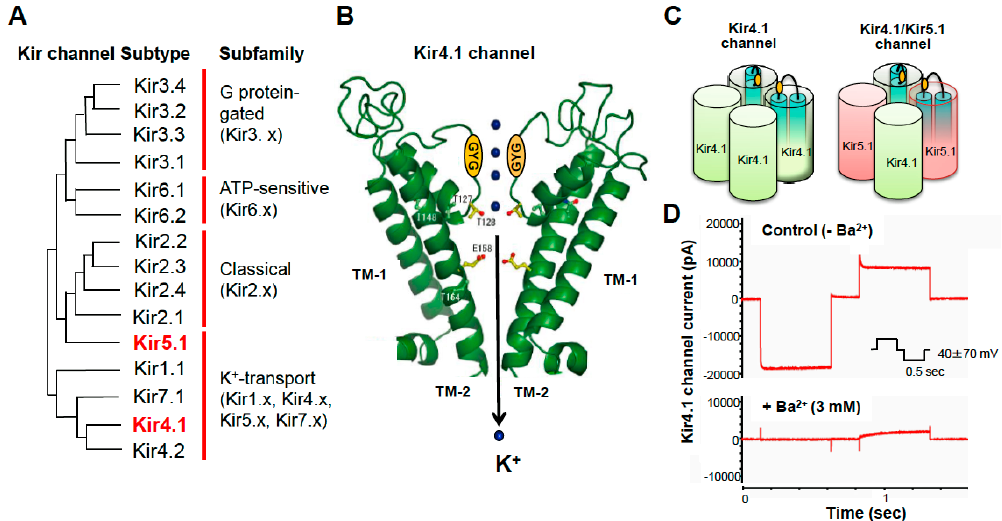
Figure 1. Molecular structure and channel properties of Kir4.1 channels. ( A ) Classification of Kir channels and their phylogenic tree. Kir channels consist of 15 subtypes which can be classified into seven families. ( B ) Kir4.1 subunits have two TM structures (TM-1 and TM-2) with one extracellular loop which contains a signature sequence: (GYG) participating in ion-selective filtering for K + . ( C ) Kir4.1 subunits form two types of Kir4.1 channels, the homo-tetramer of Kir4.1 (Kir4.1) and the hetero-tetramer of Kir4.1 and Kir5.1 (Kir4.1/5.1). ( D ) Kir4.1 channels conduct large inward and smaller outward K